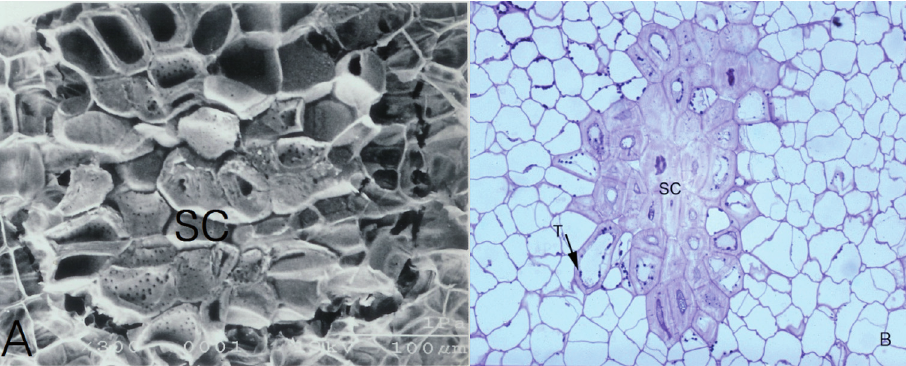
Fig. 4: Morphology of stone cells within a cluster in the flesh of ‘Niitaka’ pear under SEM (A: 300×) and optical microscope (B: 200×) on 60 DAFB. T: tannin, and SC: stone